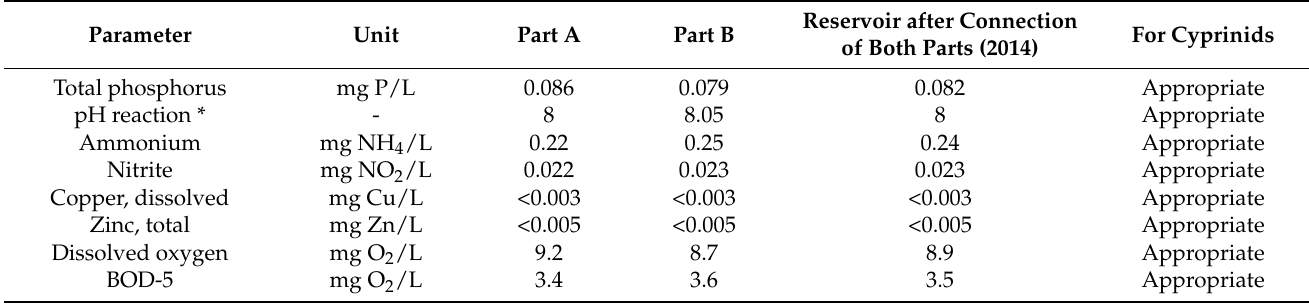
Table 4. Water quality parameters (mean values) for the estimation of the usefulness of the reservoir for living cyprinids fish species during the period